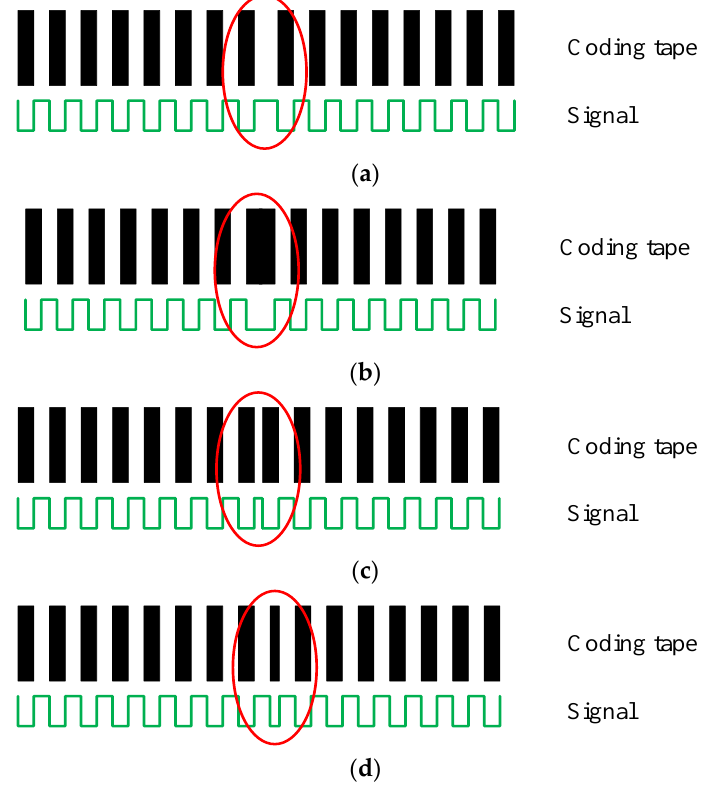
Figure 8. Condition of the code tape overlap. ( a ) The white stripes at the lap are wider than the others. ( b ) The black stripes at the lap are wider than the others. ( c ) The white stripes at the lap are narrower than the others. ( d ) The black stripes at the lap are narrower than the others.